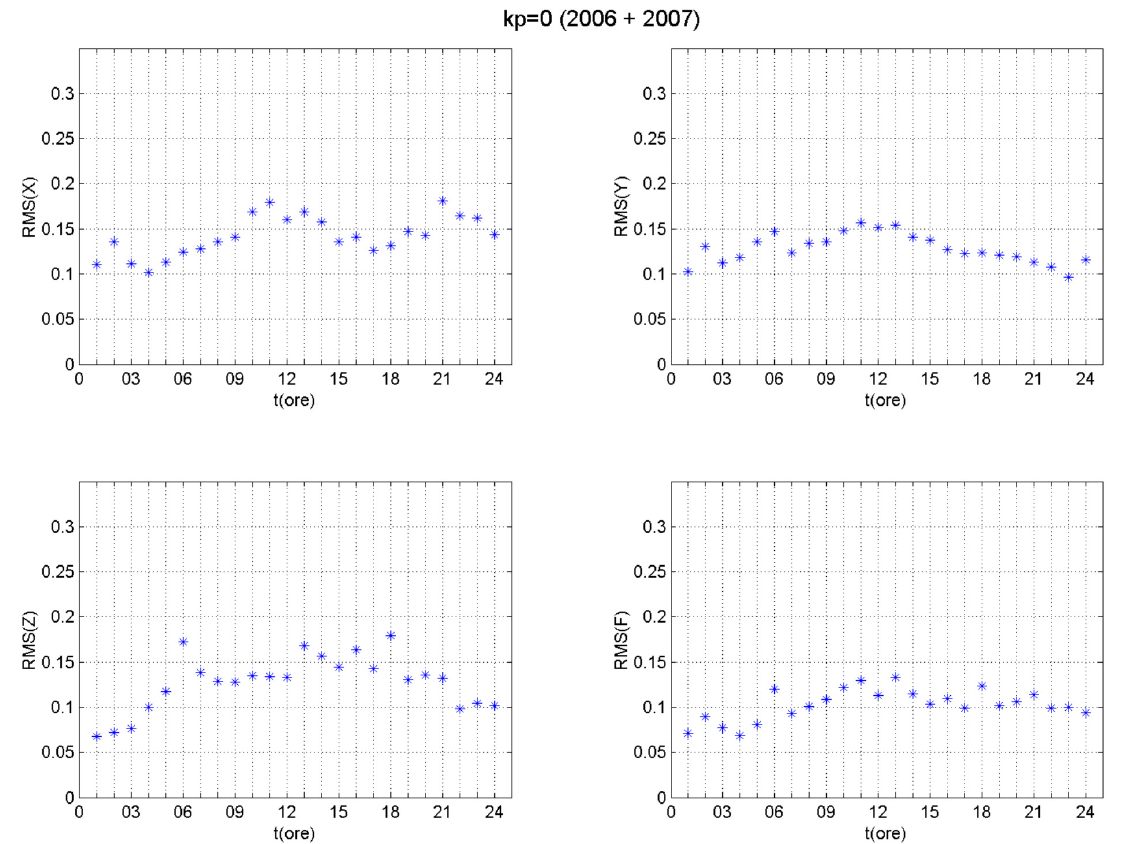
Figure 16 (left and right panels). Daily distribution of RMS during 2006 and